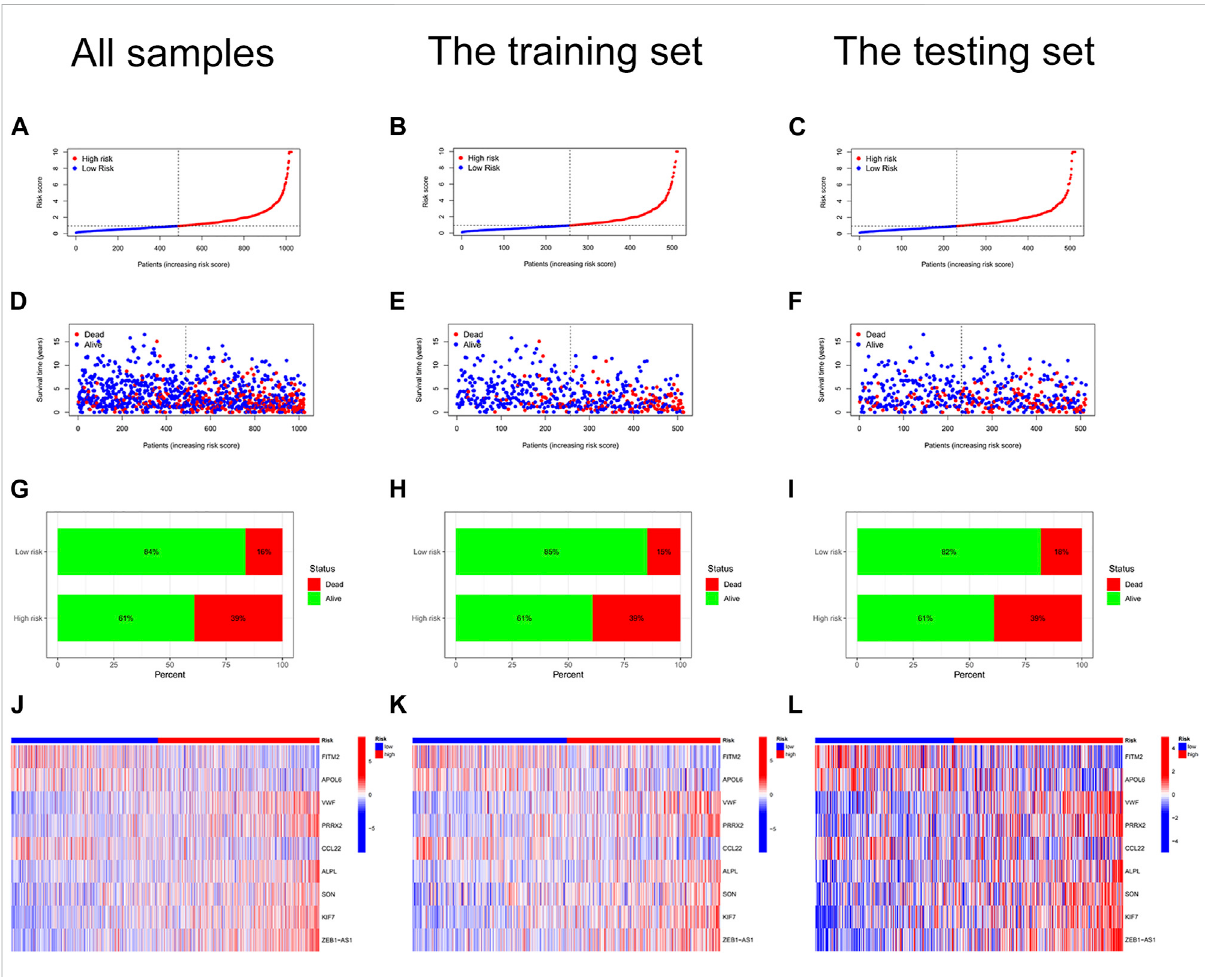
FIGURE 4 Risk curves. (A) Risk status plot of all colon cancer samples. The horizontal coordinate represented the ranked patients, and the risk scores of patients gradually increased from left to right; the vertical coordinate represented the risk scores. (B) Risk status of the training set. (C) Risk status of thetestingset. (D) Survivalstatusplotofallcoloncancersamples. (E) Survivalstatusplotofthetrainingset. (F) Survivalstatusplotofthetestingset. (G) Risk histogram of all colon cancer samples. The percentage of survival patients in the low-risk score group was higher than that in the high-risk score group. (H) Risk histogram of the training set. (I) Risk histogram of the testing set. (J) Risk heat map of all colon cancer samples. The expression of FITM2, APOL6, and CCL22 decreased with increasing risk scores; the expression of VWF, PRRX2, ALPL, SON, KIF7, and ZEB1-AS1 increased with increasing risk scores. (K) Risk heat map of the training set. (L) Risk heat map of the testing